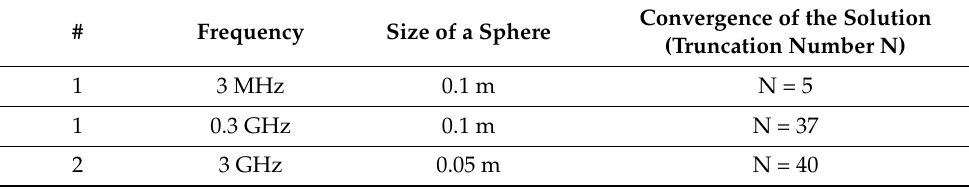
Figure 8. Representation of the truncation variation sum N ( left ) and its convergence solution with the variation of different frequency f = 3 M, f = 0.3 G, f = 3 G ( right ). Table 1. Variation of truncation number N with respect to